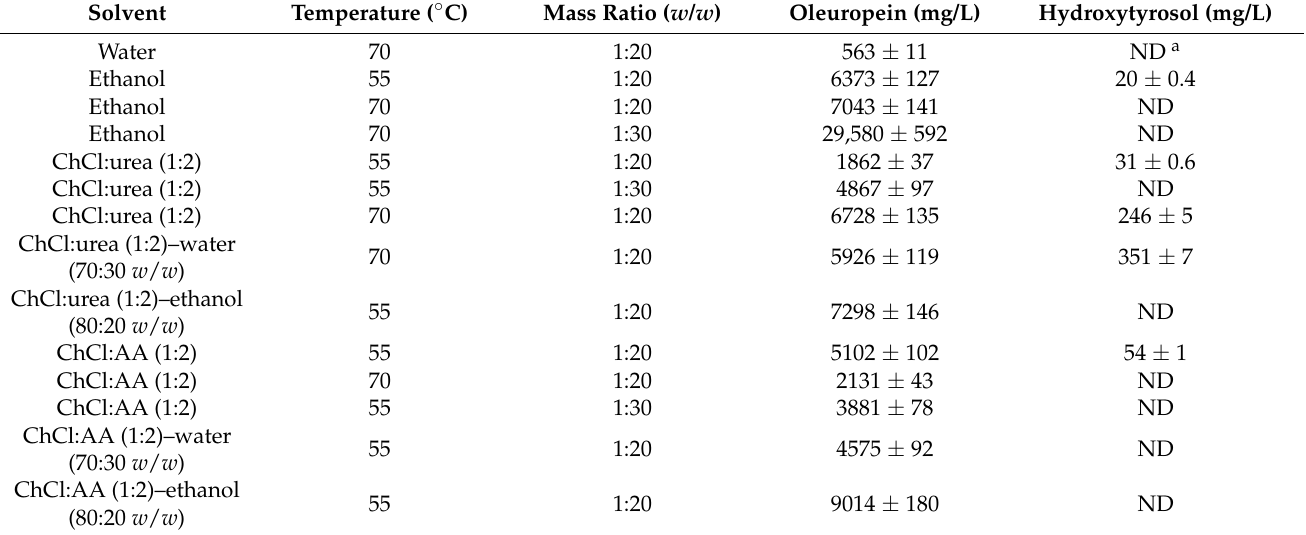
Table 2. Oleuropein and hydroxytyrosol concentrations of the extracts obtained by conventional